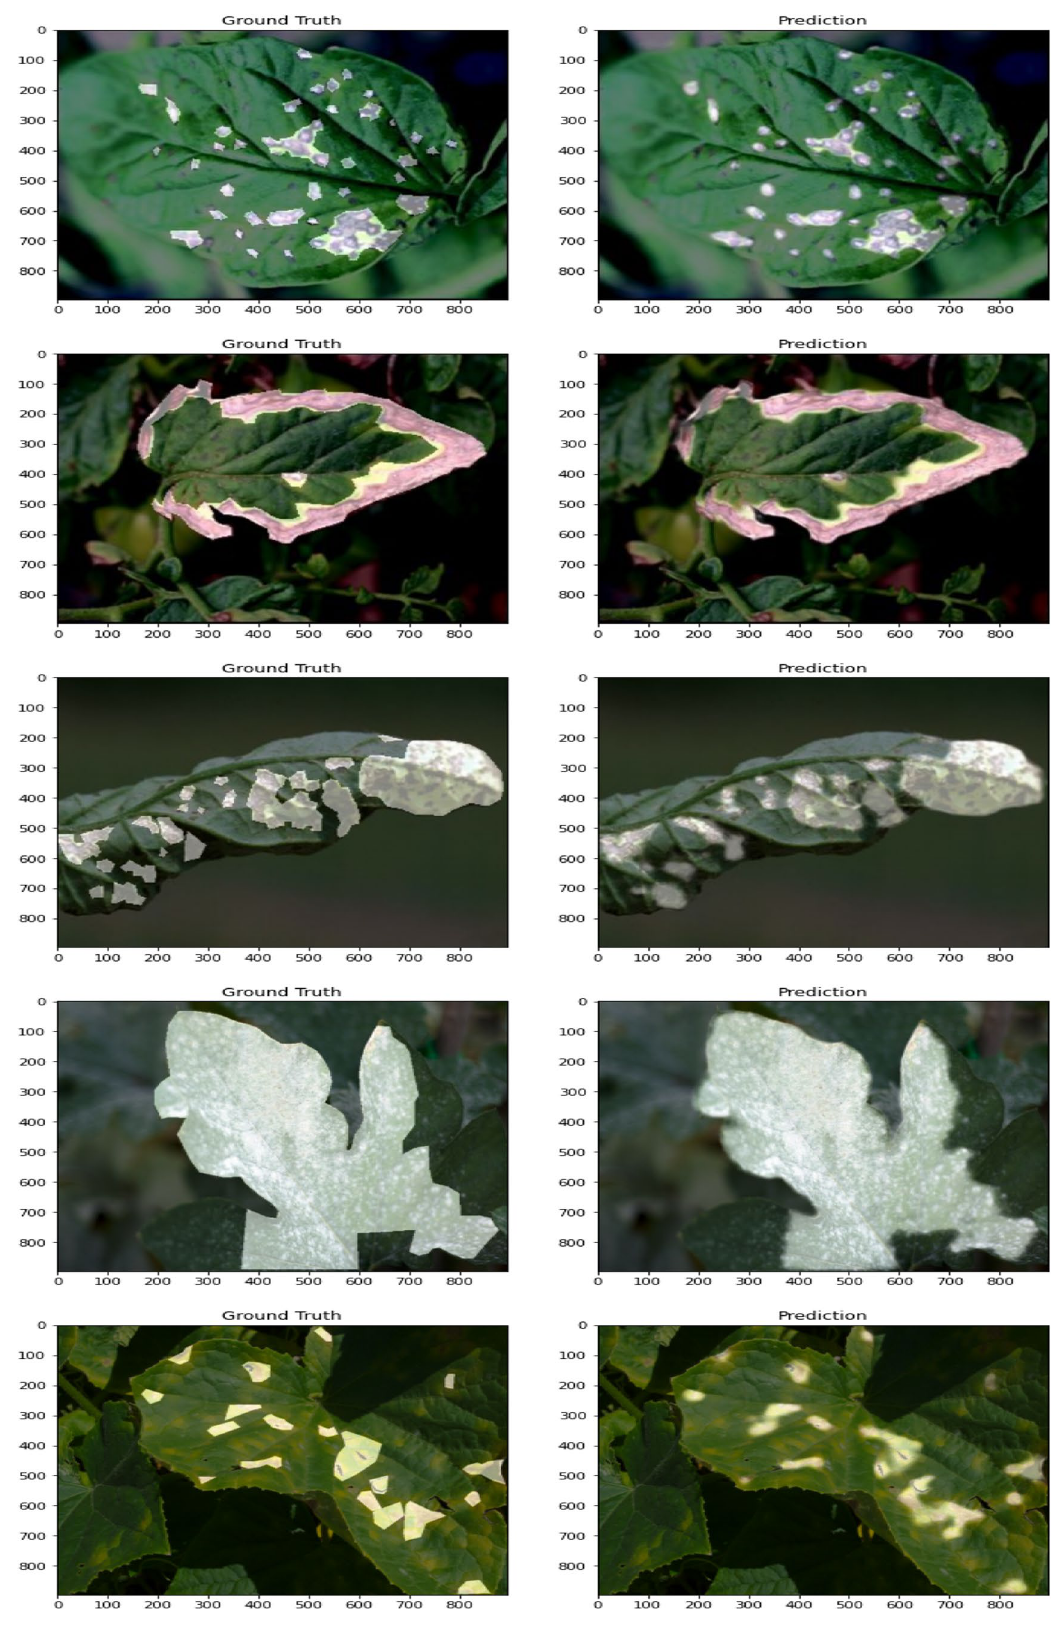
Fig. 11 Some Ground Truth against prediction samples obtained by Ced-Net